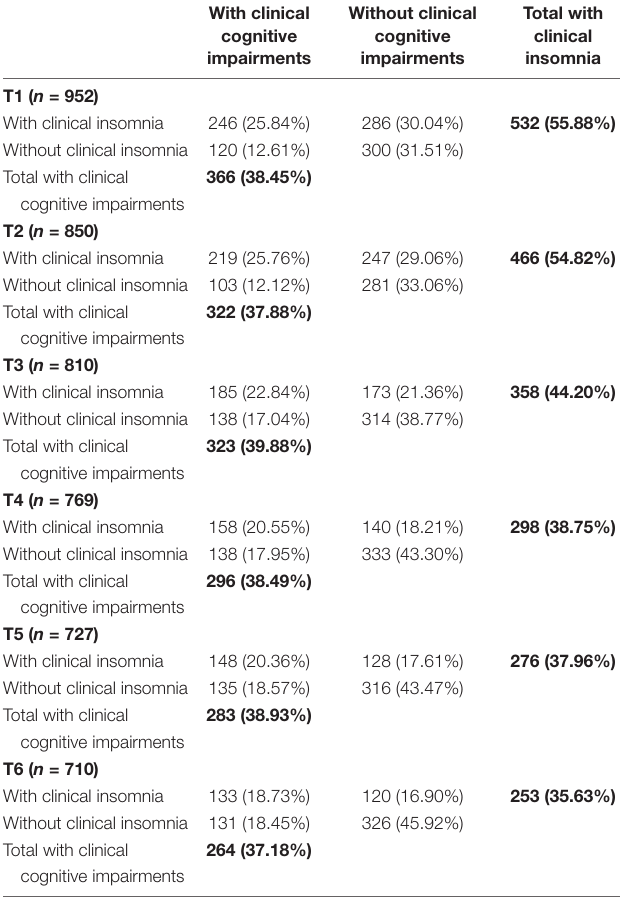
TABLE 2 | Rates (n;%) of clinical levels of insomnia and perceived cognitive impairments and comorbidity